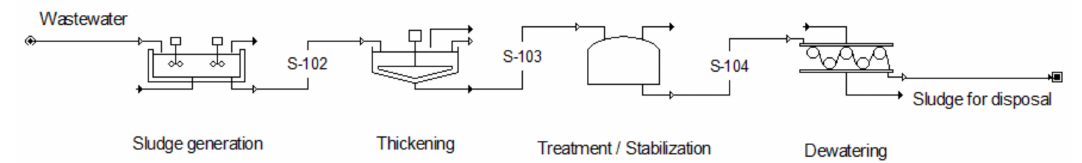
Figure 1. Scheme of sludge